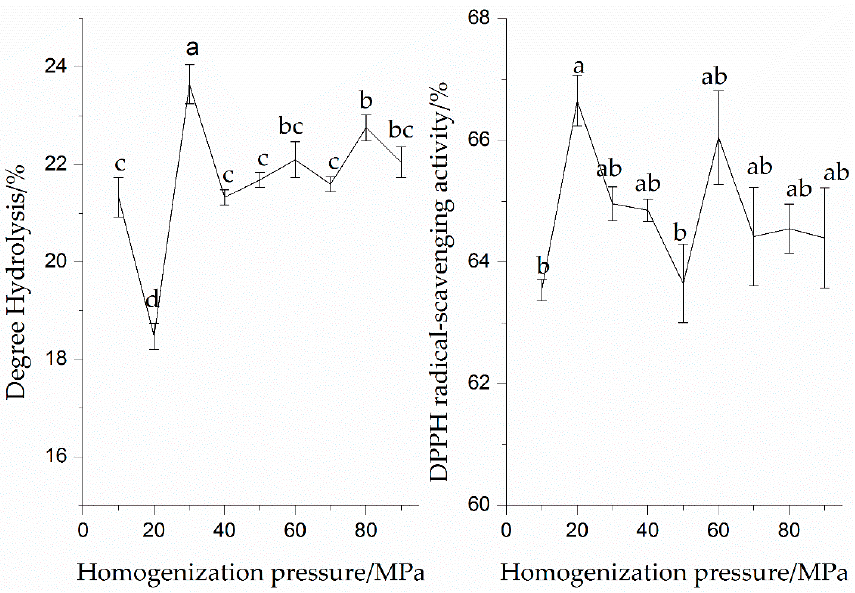
Figure 2. Effect of homogenization pressures on enzymatic hydrolysis and DPPH radical-scavenging activity of the SPI hydrolysates. Values with different letters in the same column are significantly different according to Duncan’s multiple range test ( p < 0.05).